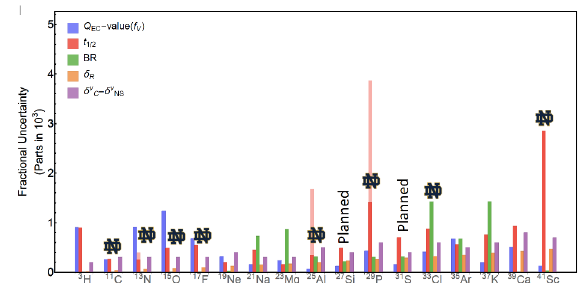
Figure 5. Fractional errors for f v values of mixed-mirror transi- tions.